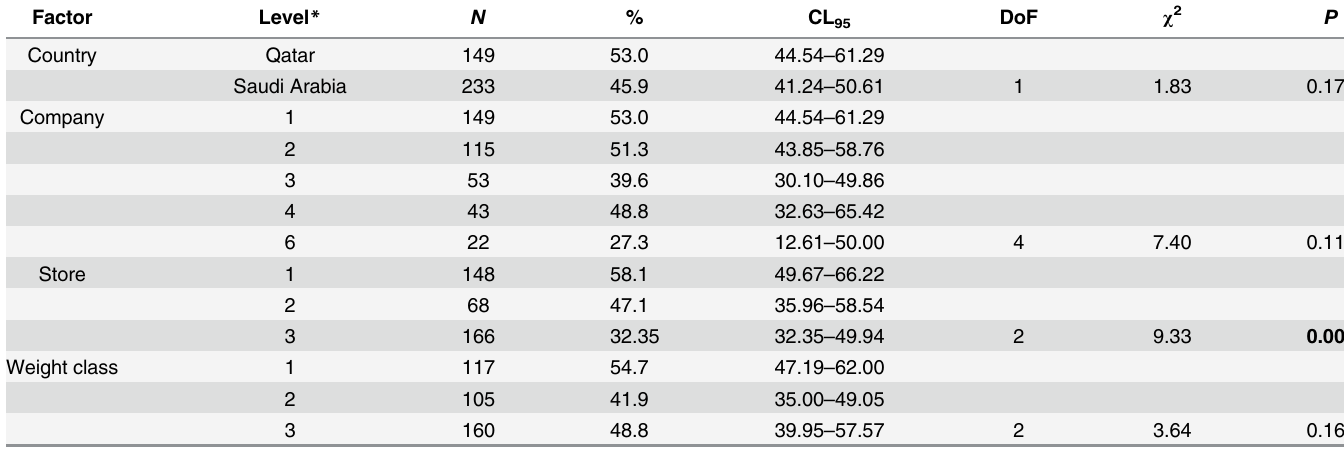
Table 1. Prevalence (%) of C . jejuni by country in which the producer was based, the company providing chickens, the store selling the chickens and the weight class of samples chickens. Factor Level *